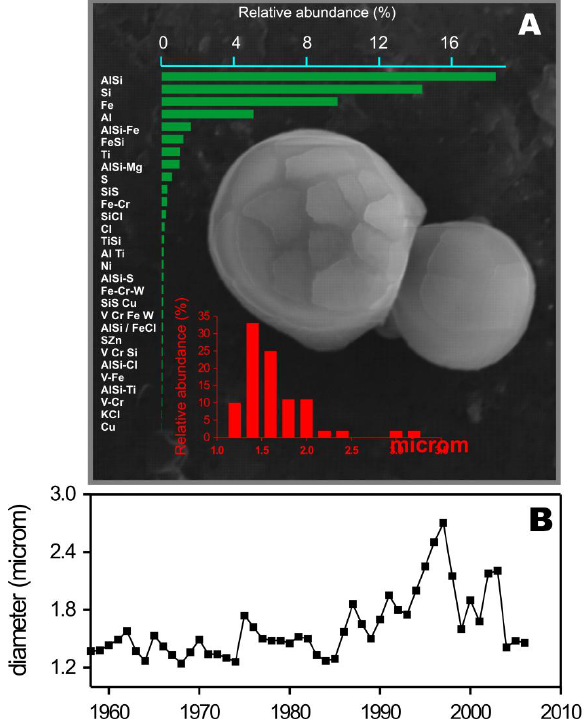
Fig. 3. (A) Size distribution of insoluble microparticles and relative abundance of elements/chemical compounds obtained for Mount Johns ice core (central West Antarctica); (B) time variability of mi- croparticle diameters at the same site.